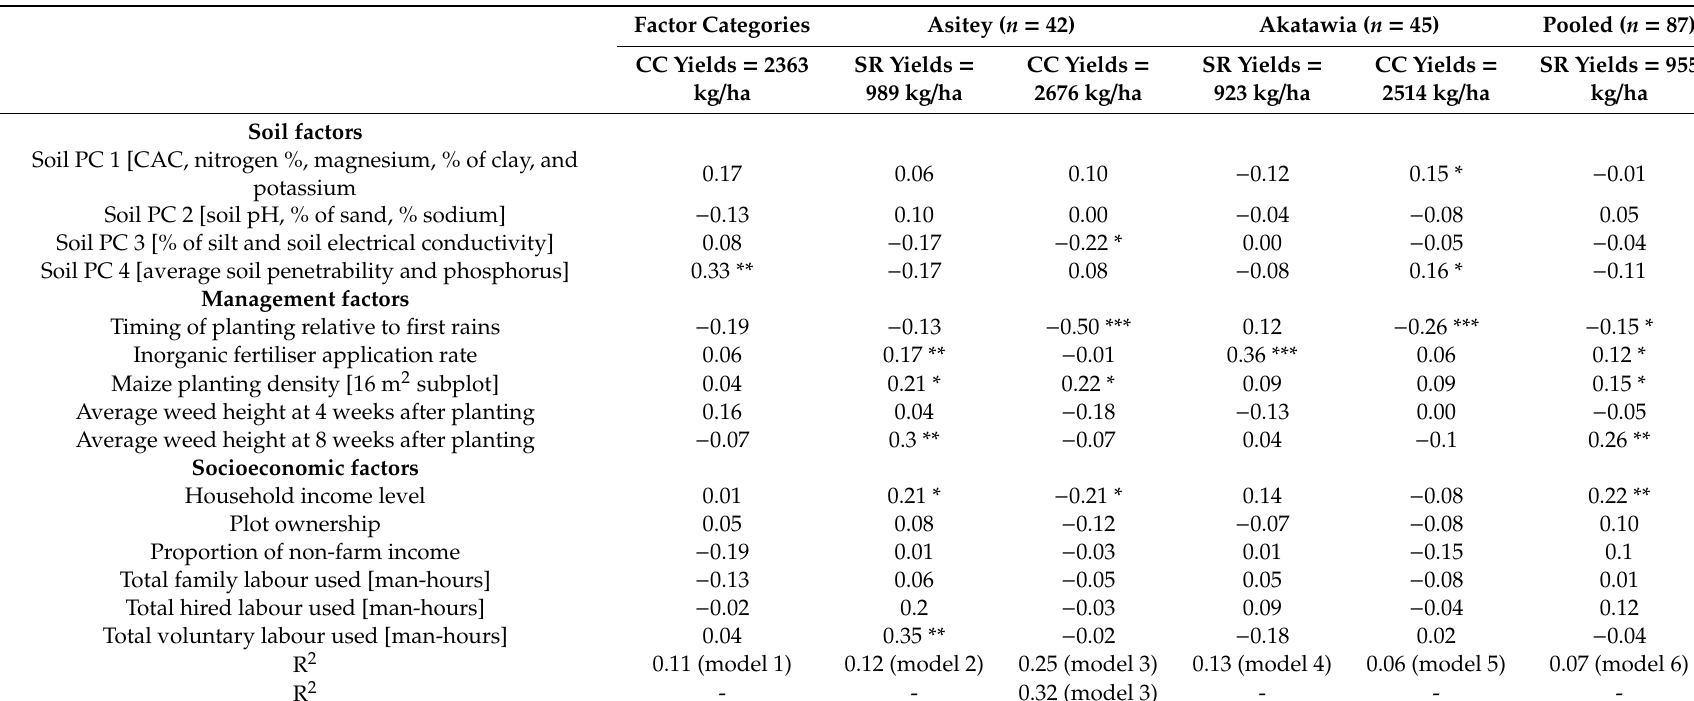
Table 5. Yield determinants from the multiple linear regression models of soil, management, and socioeconomic factors for Asitey, Akatawia and the pooled dataset. Dependent variables are the crop cut measured yields and farmers’ self-reported